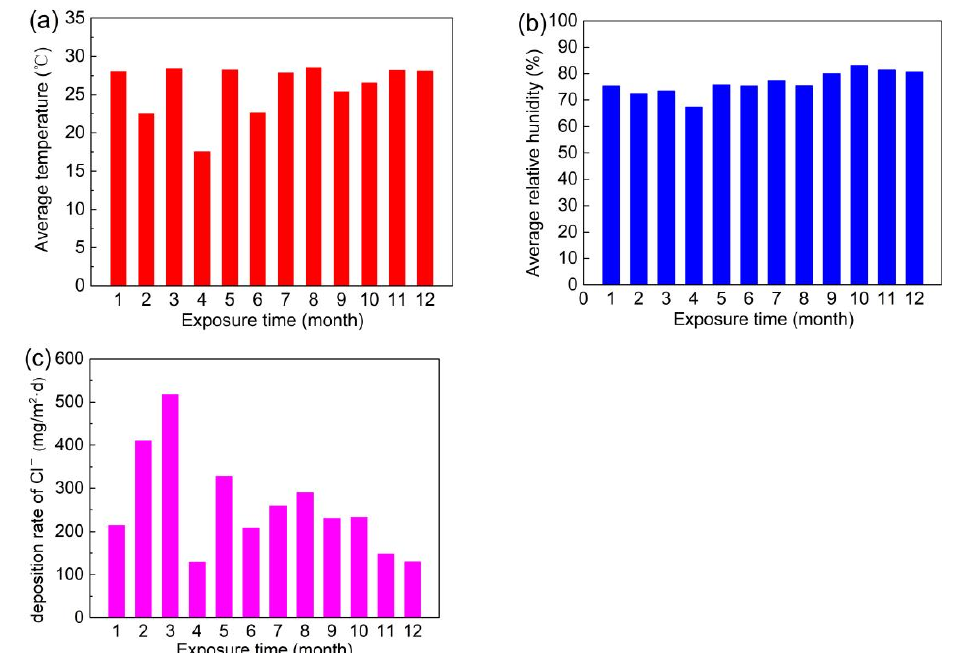
Figure 5. The monthly average values of temperature, relative humidity, and deposition of chloride ion during exposure time. ( a ) Temperature, ( b ) relative humidity and ( c ) chloride ion deposition rate .